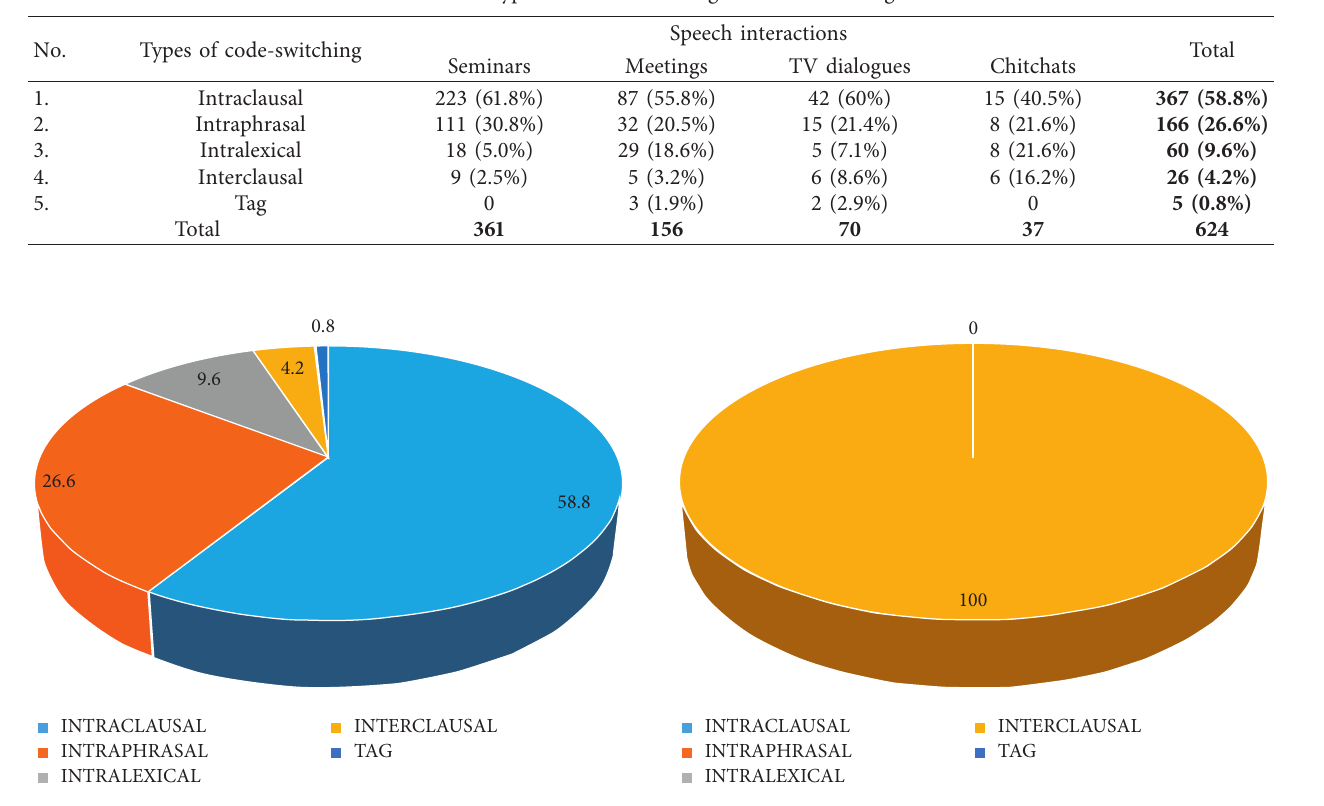
Table 5: Types of Indonesian-English code-switching.